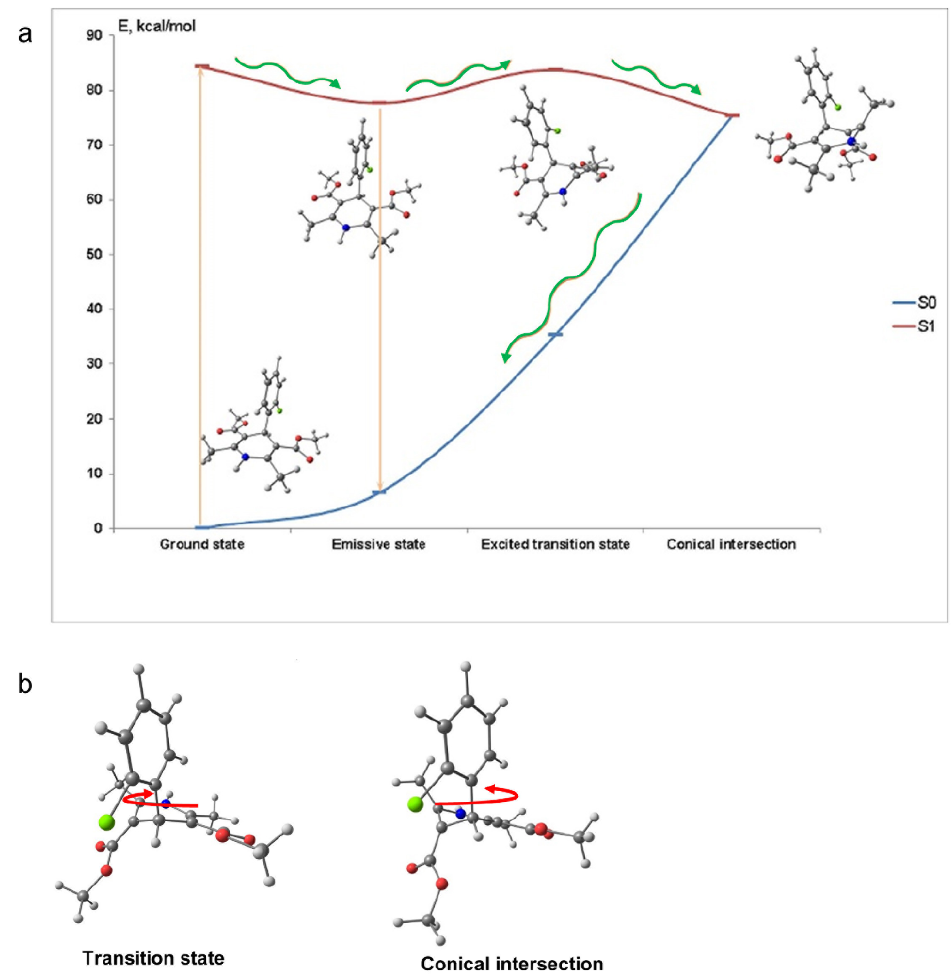
Figure 2. ( a ) Molecular conformations and potential energy surface scan of AML. The exited molecule (vertical arrow up) relaxes to the minimum of the S 1 state (wavy arrow), from which it can emit a photon (vertical arrow down). When the drug is in the viscous or crowded environment, further rotation of the 2-chlorophenyl ring is hindered, and only fluorescence is observed. In aqueous solution, the molecule can overcome the barrier from the S 1 minimum (green wavy arrow) and go to the S 1 -S 0 conical intersection (2.3 kcal/mol below the S 1 minimum, green wavy arrow), from which it will relax to the ground state non-radiatively (green wavy arrow). This leads to the fluorescence quenching. ( b ) The structures of the transition state and the conical intersection. 2-chlorlphenyl ring twist with simultaneous DHP ring puckering is shown (C-COOR group goes out of plane pertinent to the double >C=C< bond with adjacent carbon atoms). Red arrows indicate the direction of the 2-chlorophenyl ring twist to achieve the conversion from the transition state to the conical intersection and from the conical intersection to the ground state. The atomic coordinates of the model AML in the S 0 , S 1 , transition states and conical intersection are listed in Table S1, Supplementary Materials.